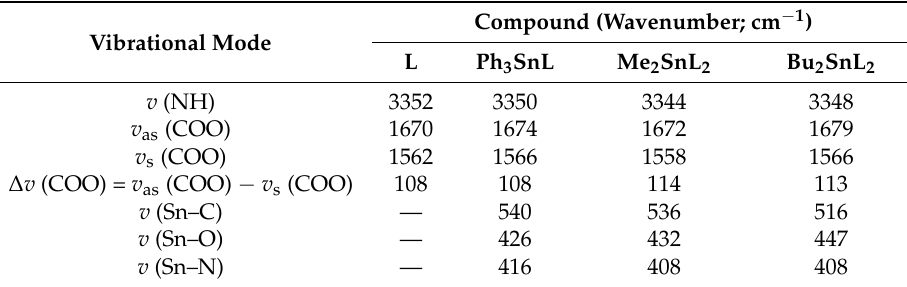
Table 2. FTIR spectroscopic data for L and its organotin(IV)